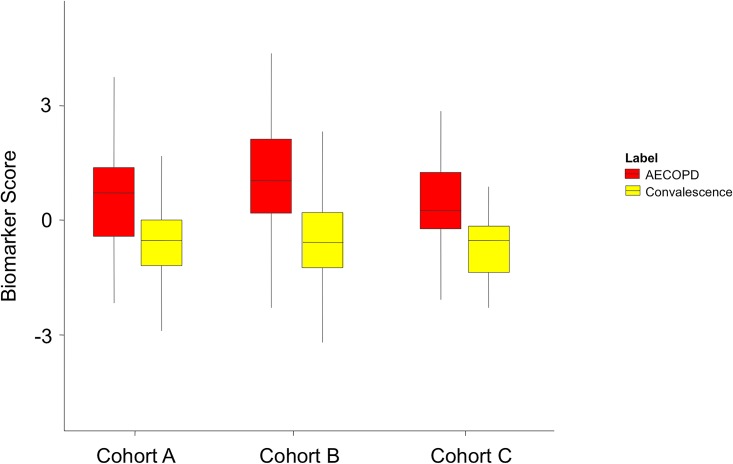
Biomarker Scores Comparing AECOPD to Non-AECOPD States.Biomarker scores for Cohorts A, B, and C are shown as box-and-whisker plots. Biomarker scores were significantly elevated during the time of AECOPD (red) but fell during the convalescent phase (yellow) (Wilcoxon rank sum p-value <0.001 for Cohorts A, B, and C). The convalescent phase scores for Cohorts A, B, and C showed no statistically significant differences.